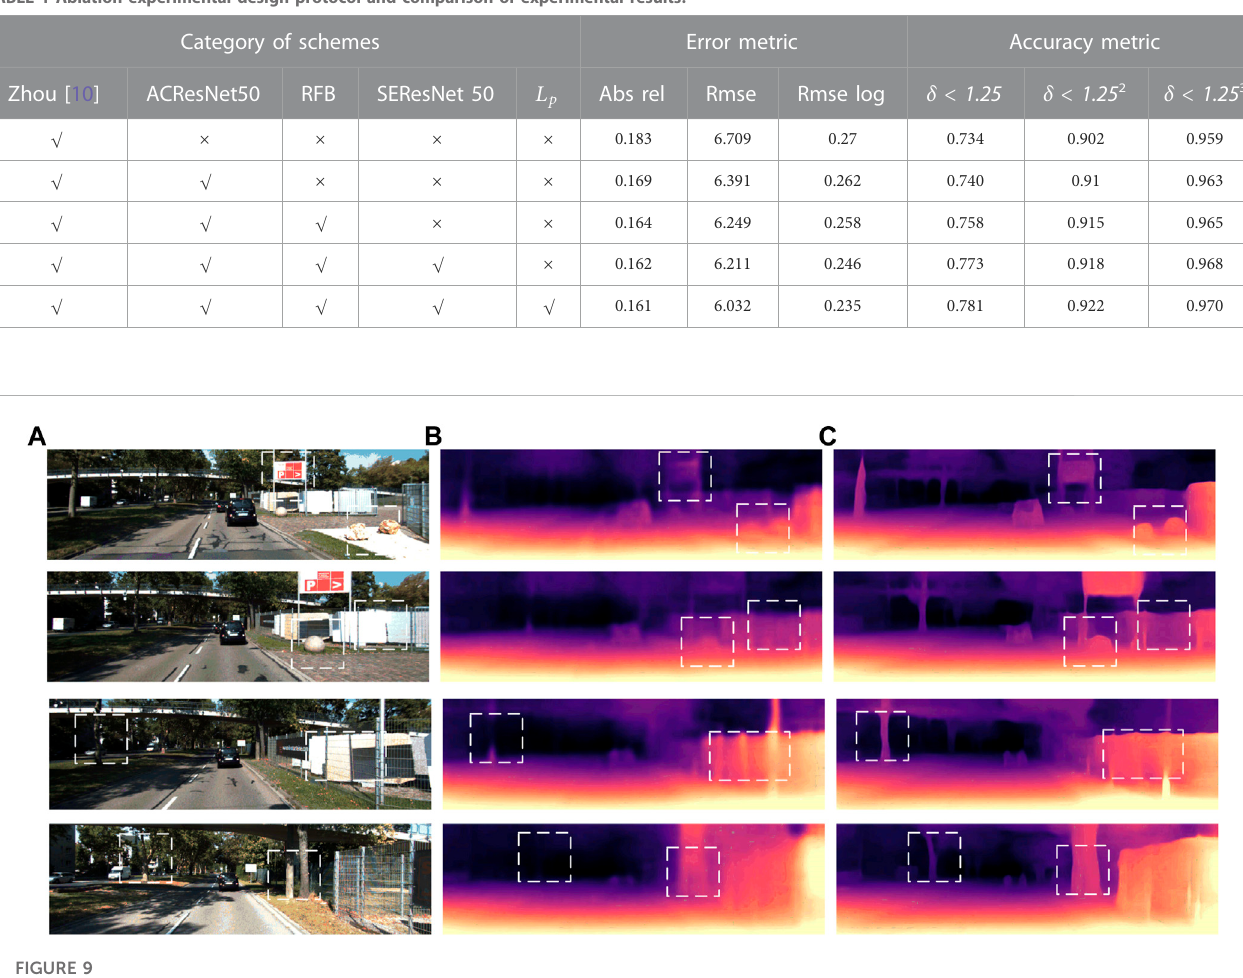
TABLE 1 Ablation experimental design protocol and comparison of experimental results.